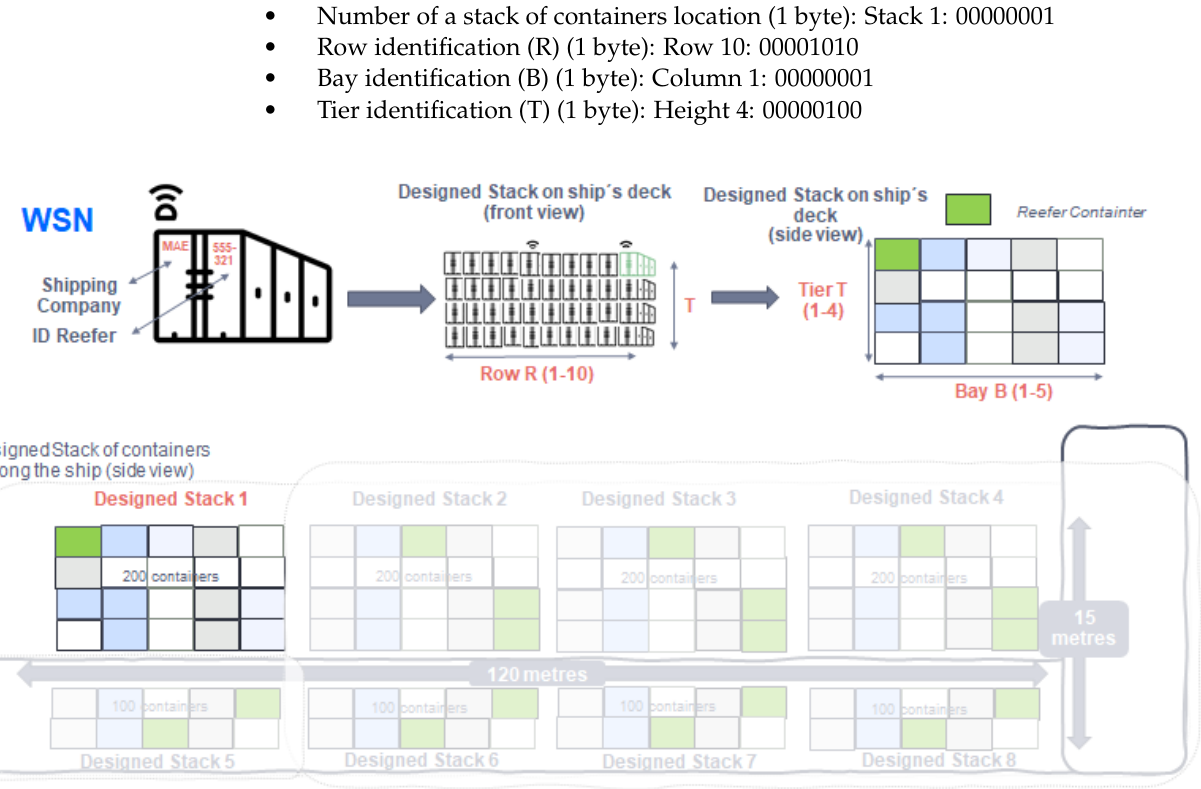
Figure 20. Manual configuration in the storage of the container location.